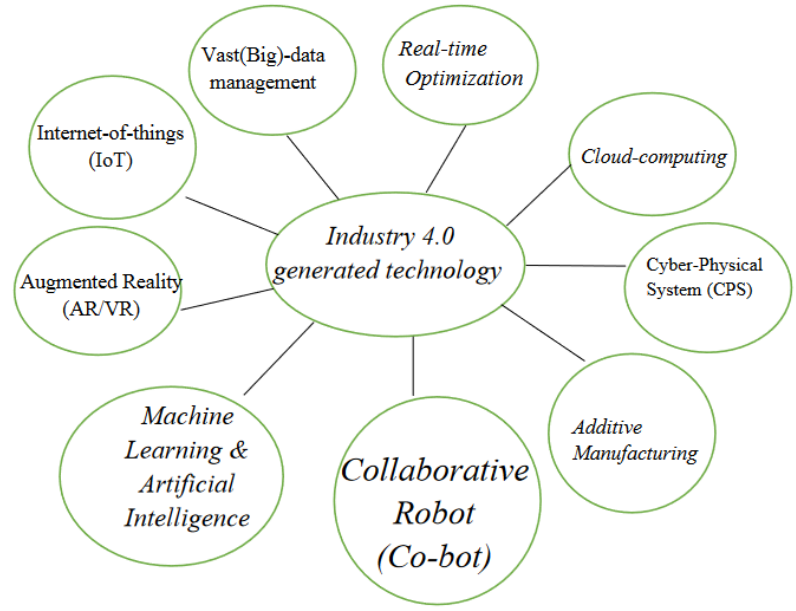
Figure 2. Enabling technologies of Industry 4.0 .